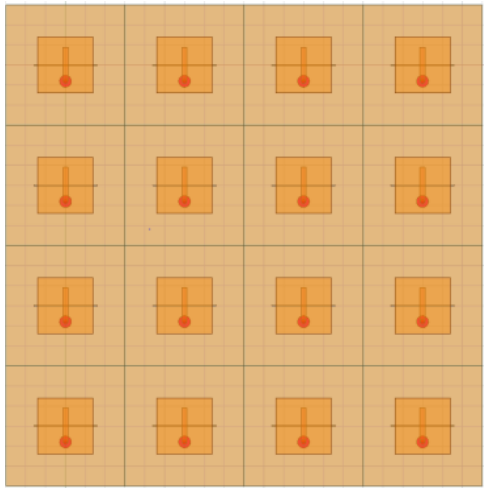
Figure 19. Geometry of reference array.